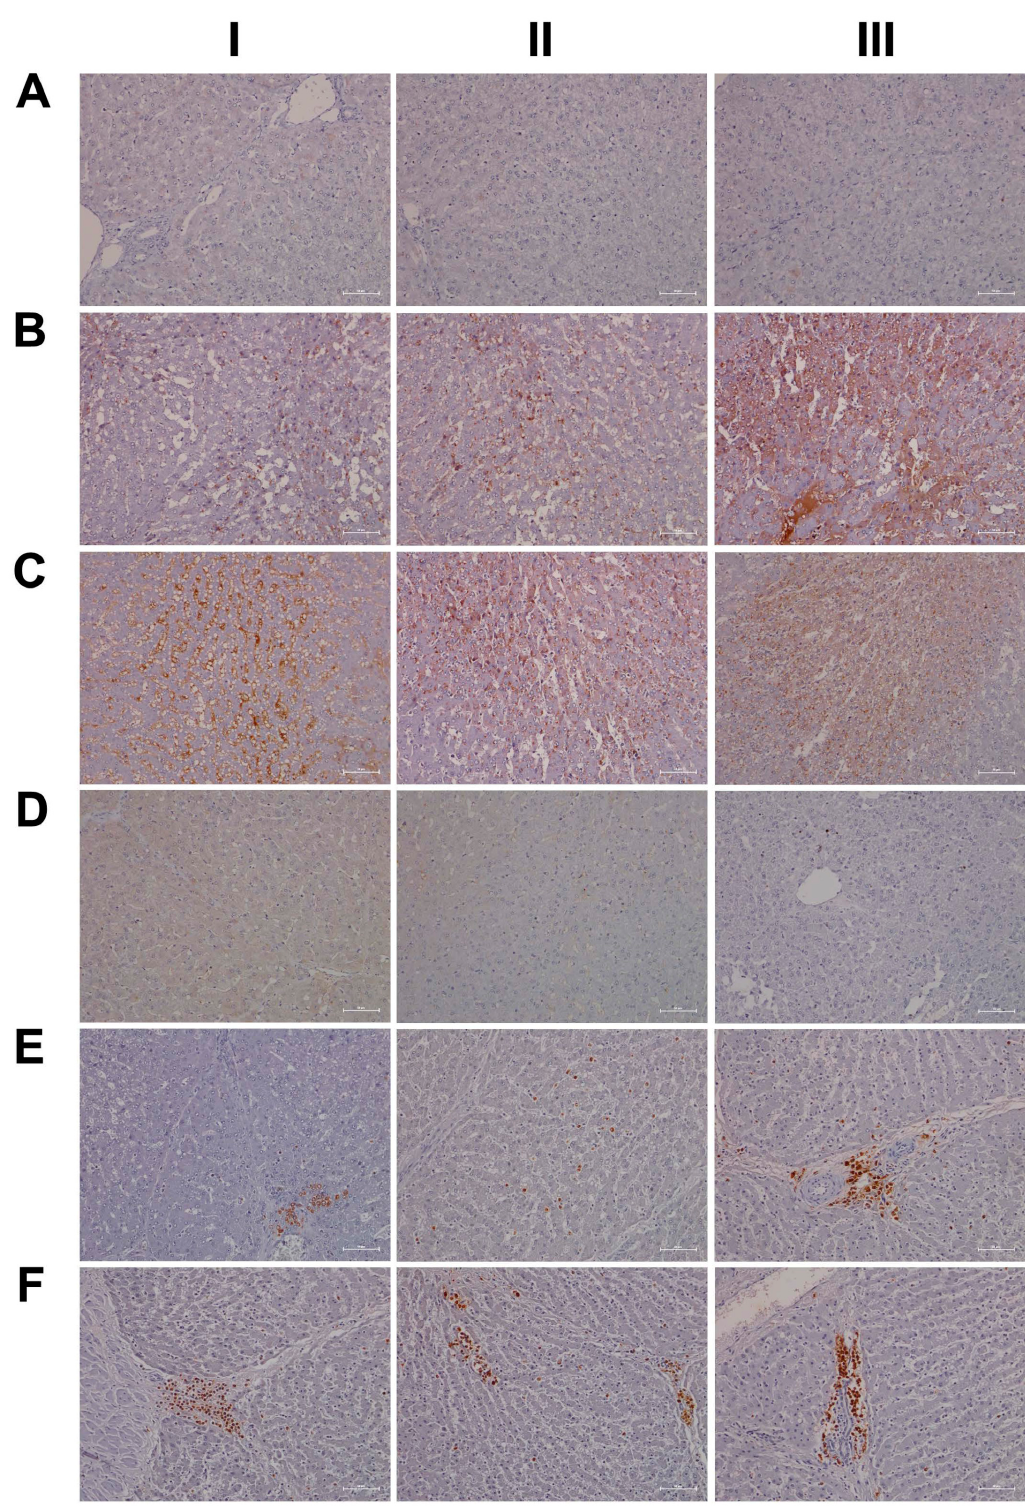
Figure 5. Immunohistochemistry of hypoxia inducible factor 1 α (HIF1 α ) and myeloperoxidase (MPO) in liver sections of control and diclofenac-treated animals after daily dosing for 28 days. HIF1 α is a transcription factor and of critical importance in regulating cell metabolism in conditions of hypoxia/ischemia, and MPO is an enzyme that catalyzes the production of diclofenac reactive metabolites which damage liver parenchyma. Panel AI–III: Liver sections of three individual control animals with no HIF1 α expression. Panel BI–III: HIF1 α staining of three low-dose-treated